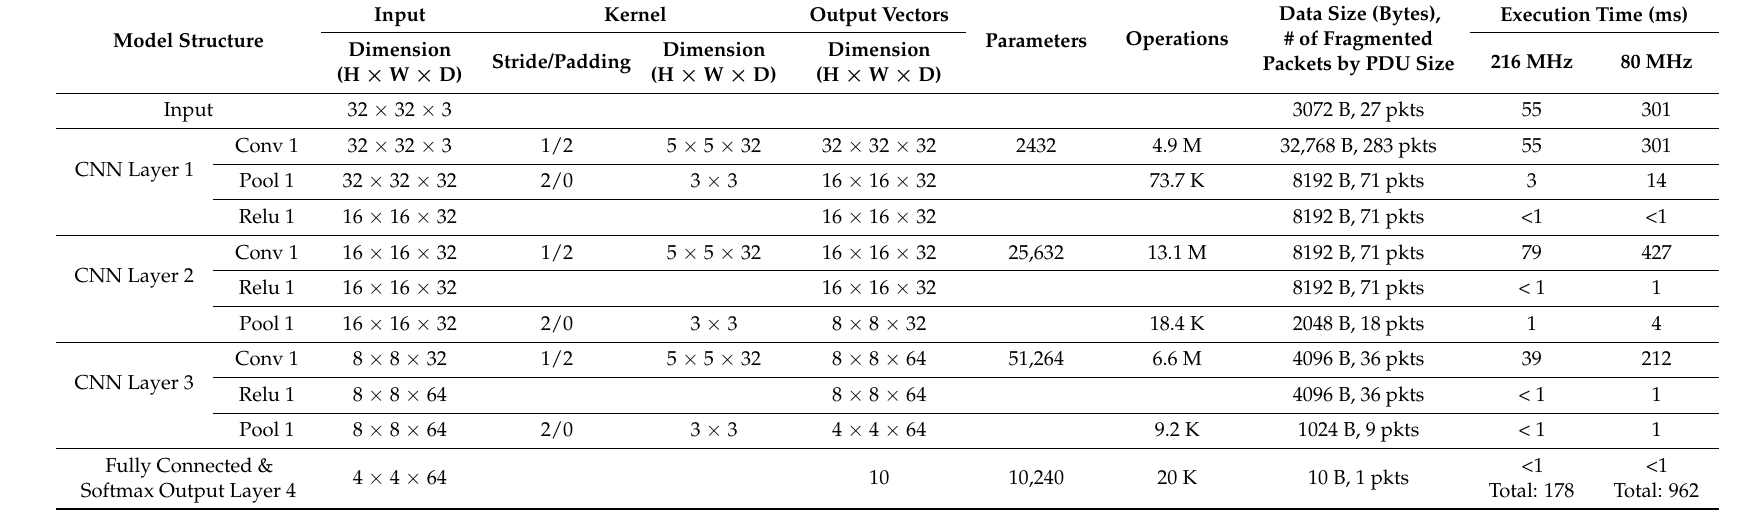
Table 2. Layer parameters and performance for the applied deep learning